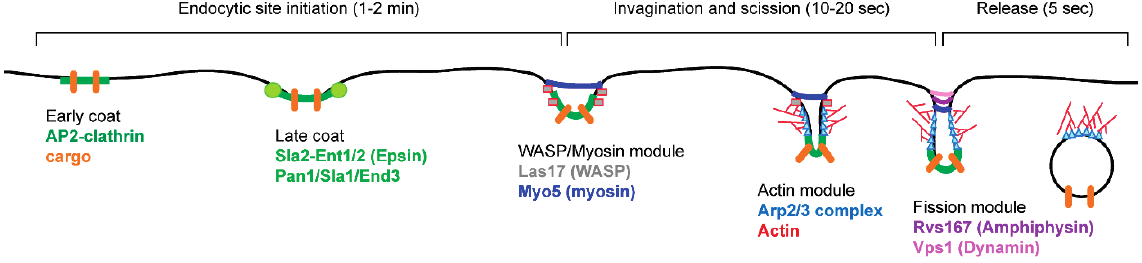
Figure 4. The endocytic internalization process. Endocytosis sites are first initiated by the recruitment of clathrin via the AP-2 adaptor complex (early coat) to cluster cargo proteins to the endocytic invagination sites at the plasma membrane (PM). Initiation is terminated by the recruitment of ANTH- (AP180 N -terminal homology) and ENTH- (epsin N -terminal homology) domain containing proteins Sla2 and epsins Ent1 and Ent2 to form the late